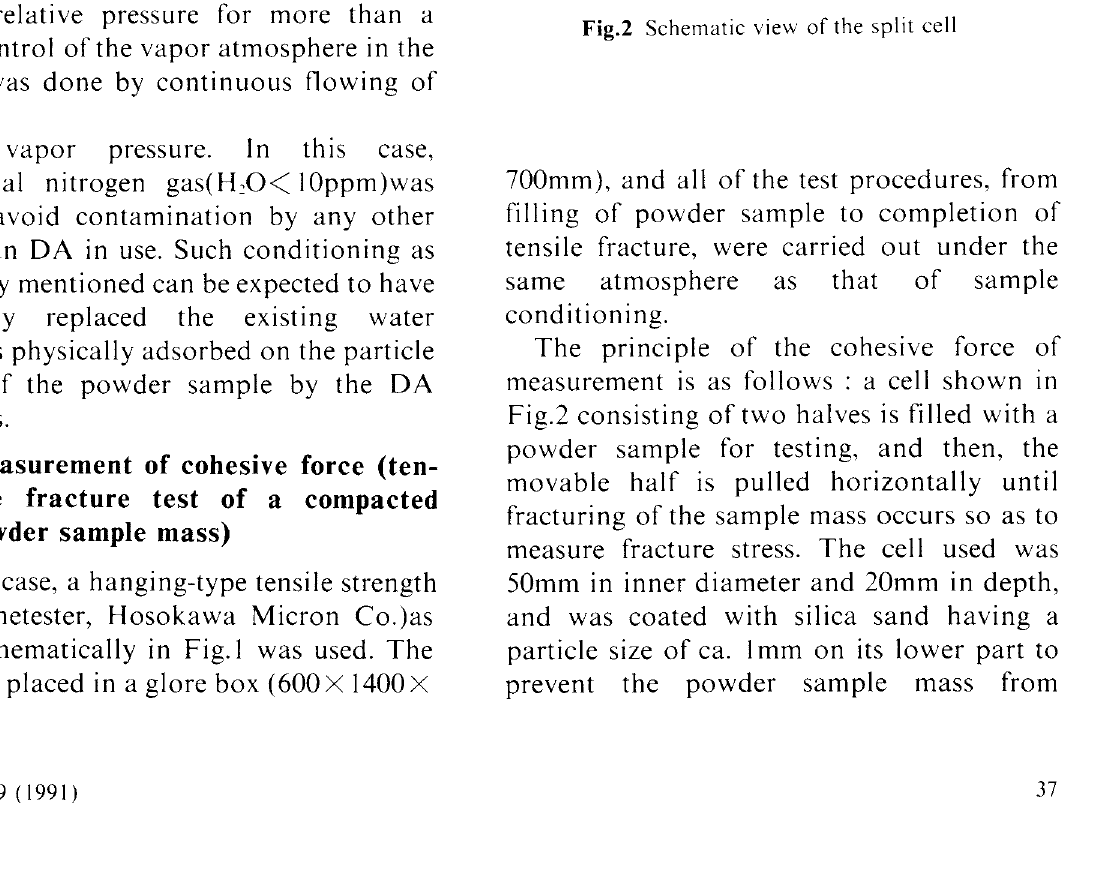
Fig.2 Schematic view of the split